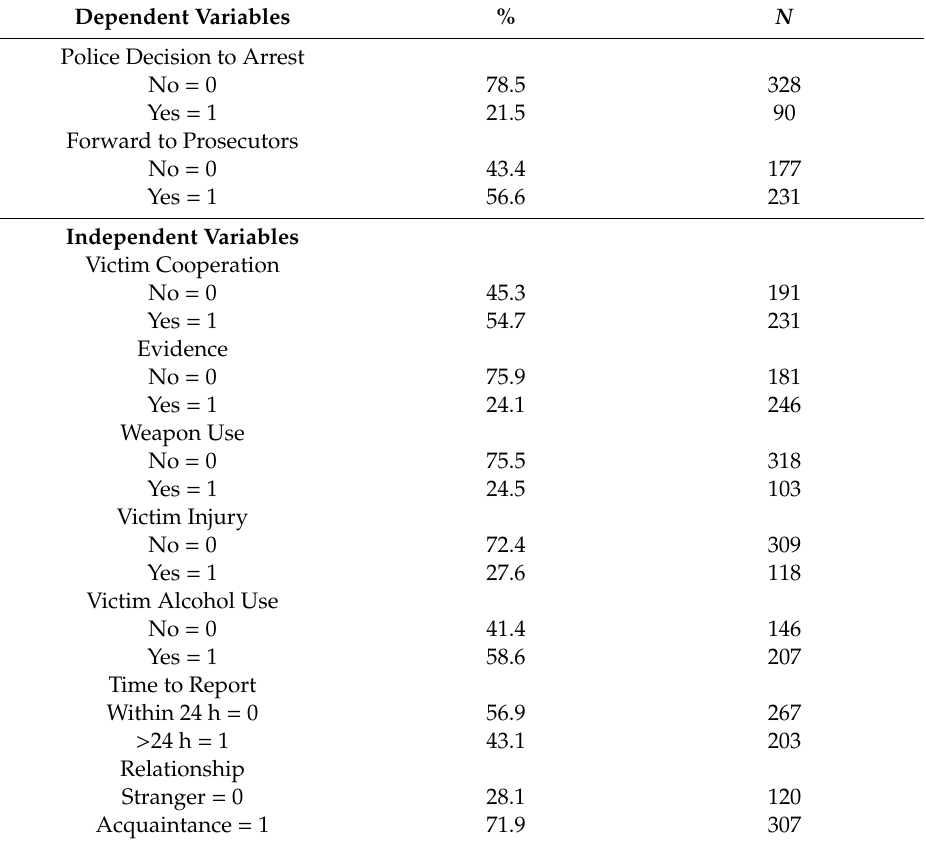
Table 1. Descriptive information for dependent and independent